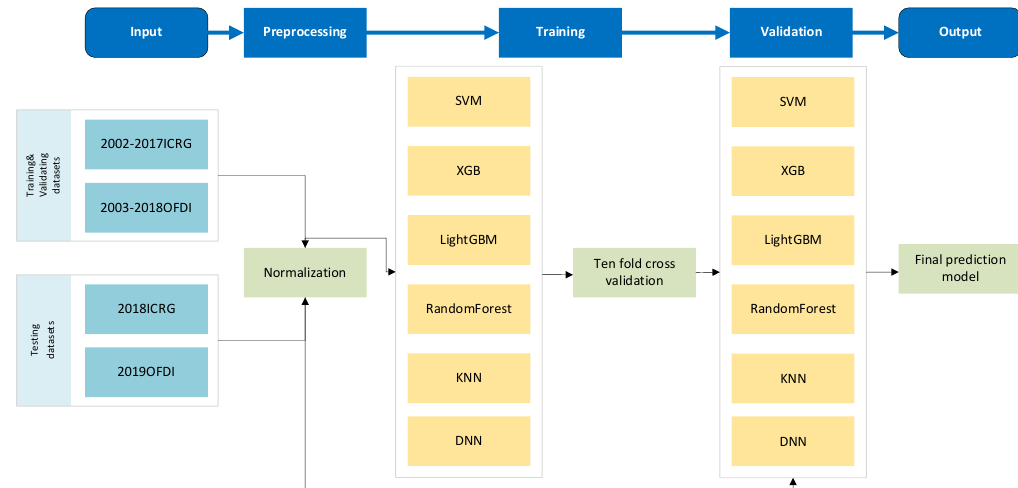
Figure 4. Flowchart of Outbound Investment Risk Prediction.